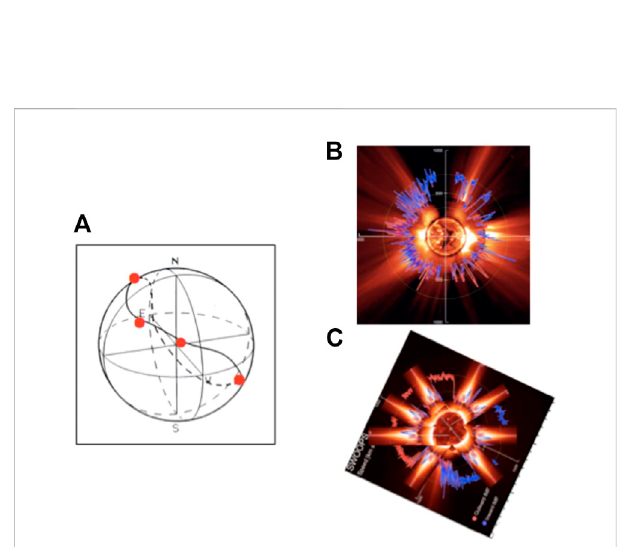
FIGURE 6 (A) The magnetic equator on the spherical source surface (CR 1720);dotsshowtheassumedlocationoftheequatorialstreamers. (B) The observed distribution(Figure 2B). (C) The constructed distribution by rotating the sun once.